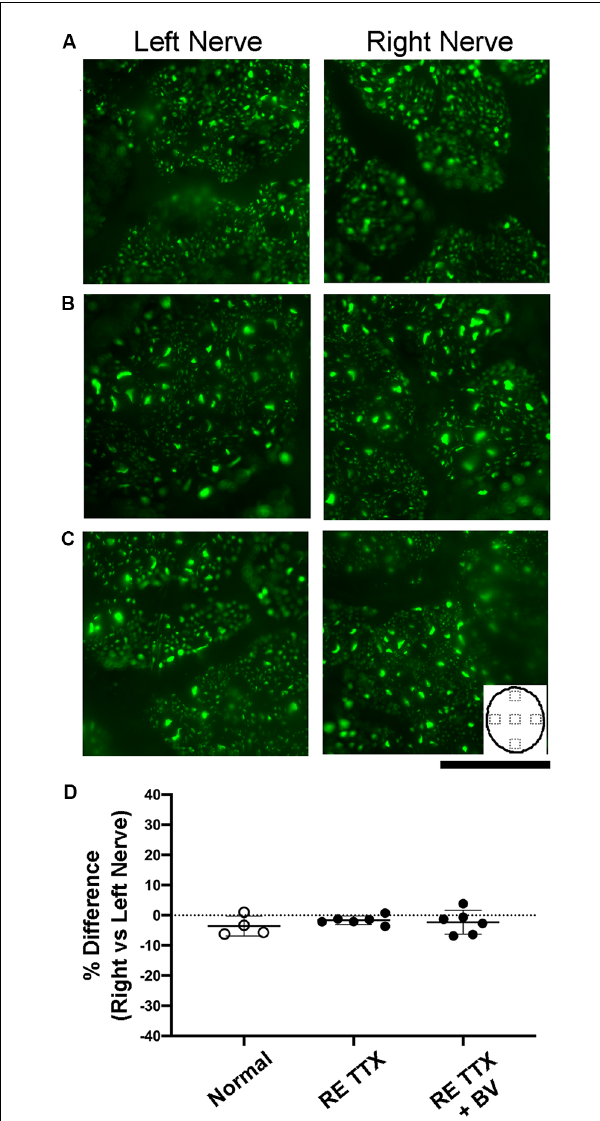
FIGURE 3 | Examination of neurofilament labeling in the left and right optic nerves following inactivation of the right eye. In normal control animals, neurofilament immunofluorescence was observed to be balanced between the left and right optic nerves (A) . Comparable neurofilament labeling between the left and right nerves was also evident in animals subjected to inactivation of the right eye for 10 days (B) , as well as in animals that were likewise treated and then permitted binocular vision after inactivation wore off (C) . Inset in C depicts an outline of the optic nerve cross-section to illustrate the location of labeling measurements. Quantification of neurofilament fluorescence (D) was expressed with an ocular index that was calculated for each animal and revealed that immunolabeling from the left and right optic nerves was balanced and not statically different between groups ( H = [3] = 0.76, p = 0.70; Dunn’s multiple comparison test: p > 0.05). Scale bar = 250 microns. that optic nerve sections from the left and right eye were indistinguishable for each group ( Figures 6A–C ), and this was supported by our measurements of fluorescence that showed